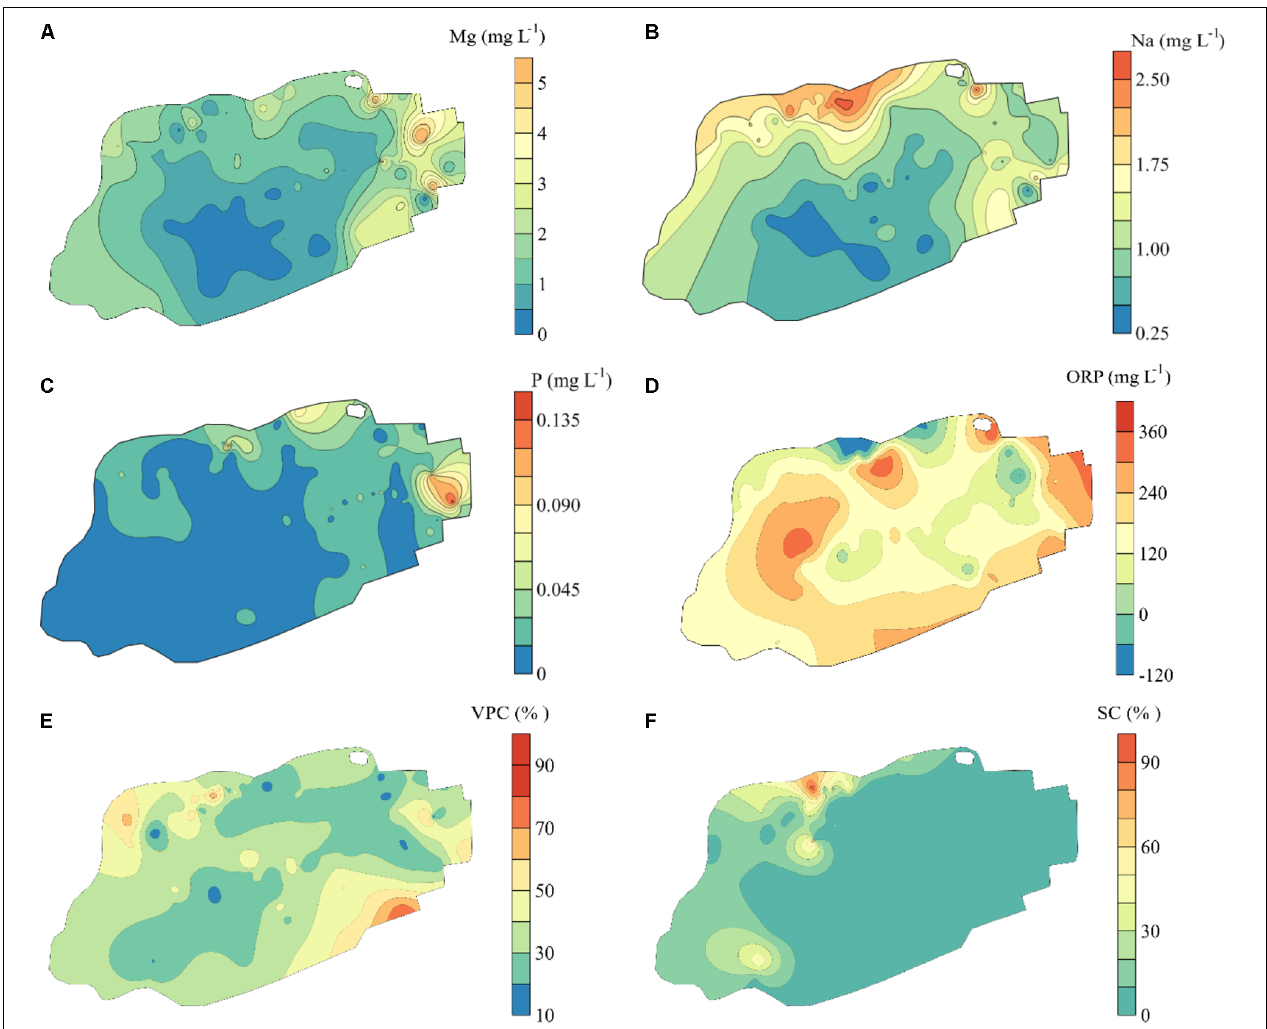
FIGURE 4 | Spatial distribution of environmental variables in Jinchuan mire based on Kriging interpolation. The environmental variables were selected by analysis of forward selection with the double-stopping criterion. (A) Magnesium (Mg). (B) Sodium (Na). (C) Phosphorus (P). (D) Adjusted oxidation–reduction potential (ORP). (E) Vascular plant cover (VPC). (F) Dwarf shrub cover (SC). Vascular plant cover was the ratio of the area of the vertical projection of vascular plants occupying the ground. Dwarf shrub cover was the index of coverage sum of all the dwarf